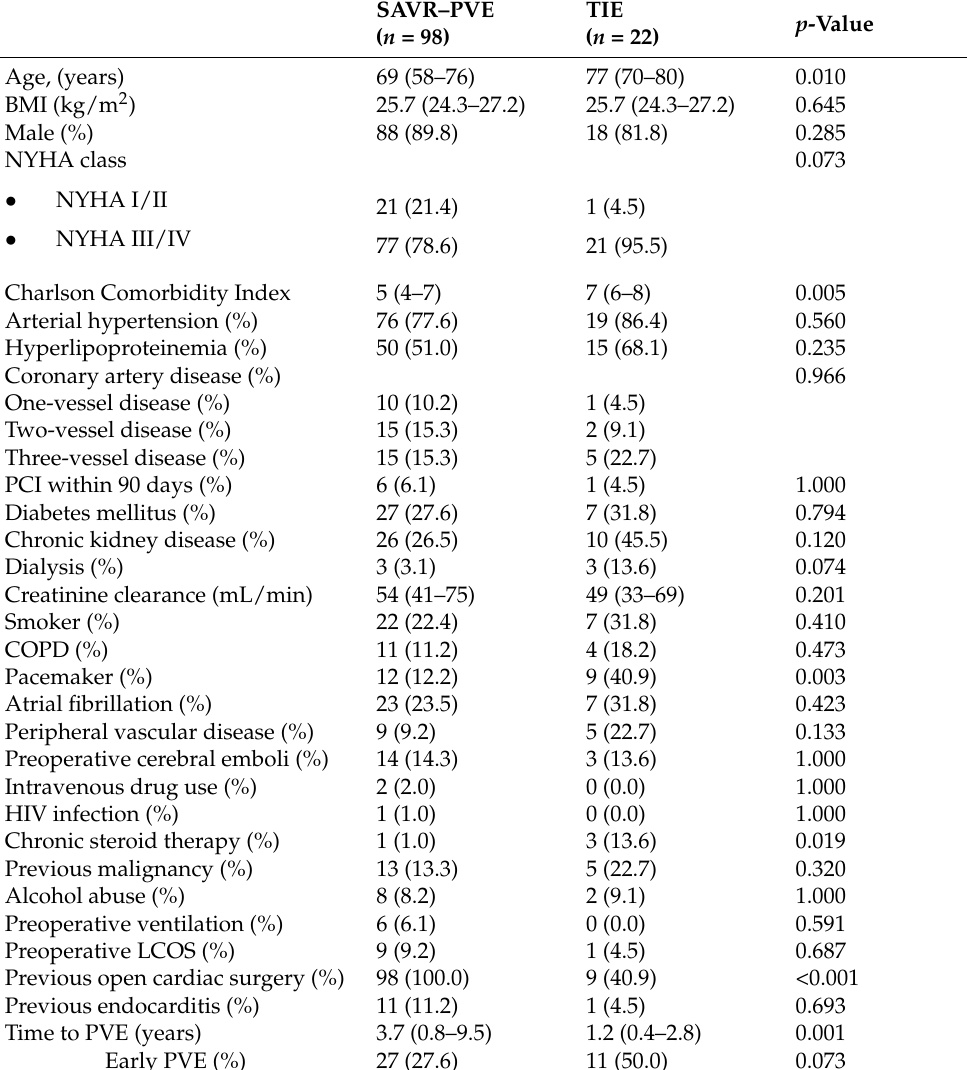
Table 1. Baseline parameters. BMI, body mass index; COPD, chronic obstructive pulmonary dis- ease; LCOS, low cardiac output syndrome; LVEF, left ventricular ejection fraction; PVE, prosthetic valve